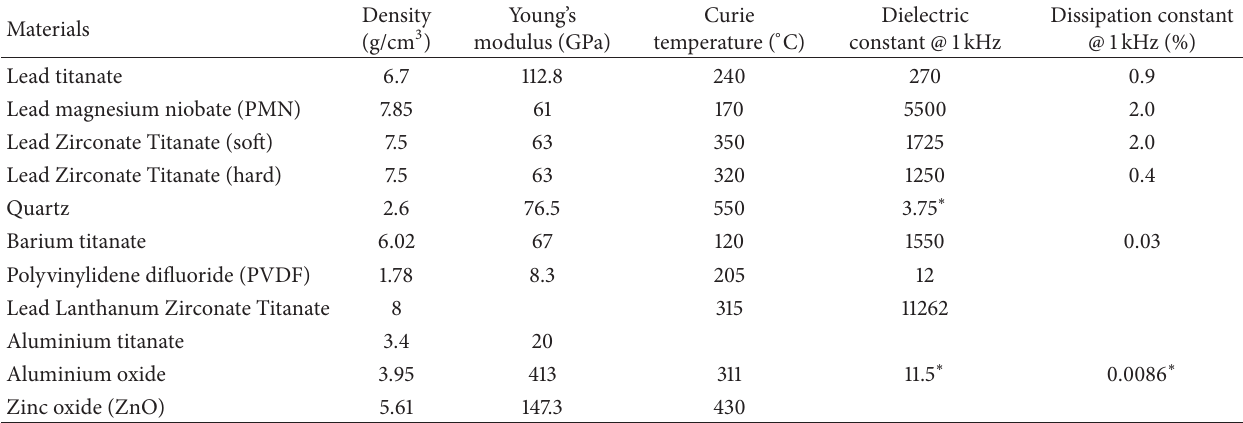
Table 3: Piezoelectric materials and their